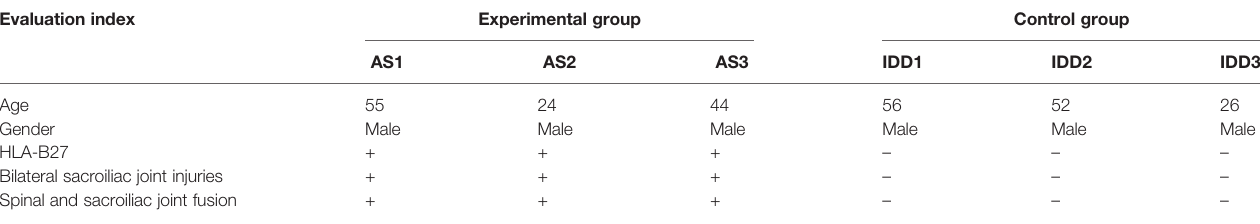
TABLE 2 | Baseline information of all cases by high-throughput